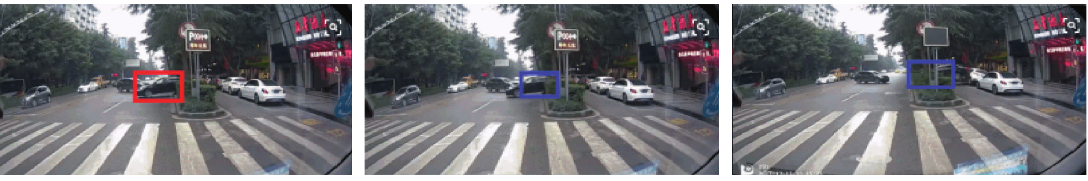
Figure 18: Monte Carlo tracking results.